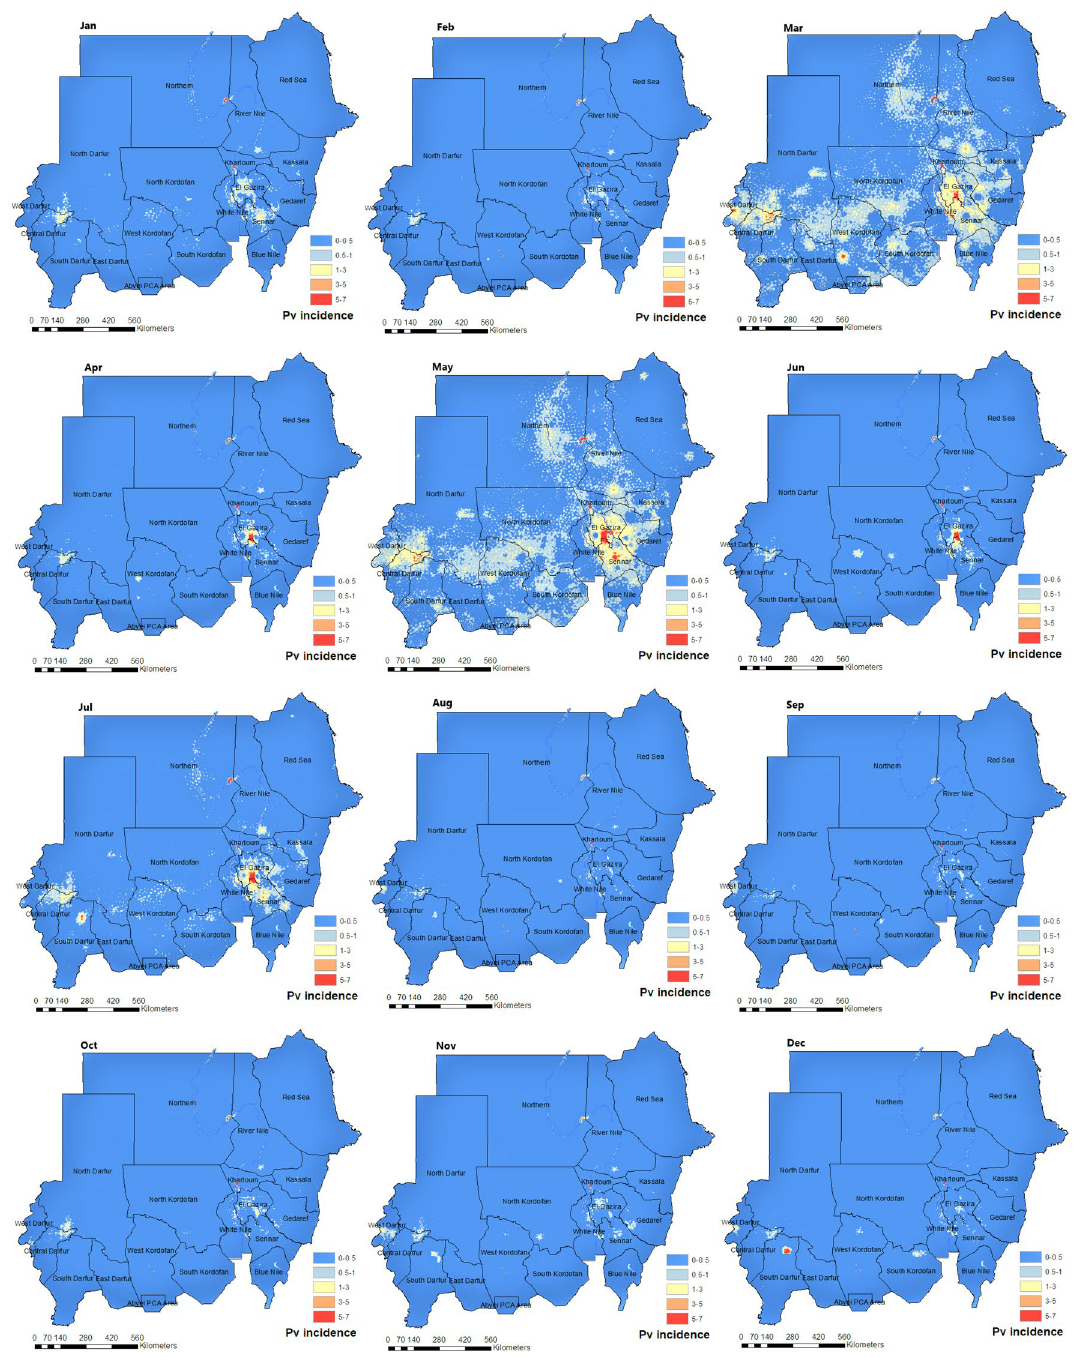
Figure 7. A fine-scale map ( 1 × 1 km) of the incidence cases of the Plasmodium vivax malaria per 1000 in each calendar month in Sudan based on our spatiotemporal Bayesian model fit to the monthly routine surveillance data between 2017 and 2019. These maps were created in ArcGIS (https:// www. arcgis. com) using the ArcMap